Question: Write a single sentence explaining what this figure depicts.
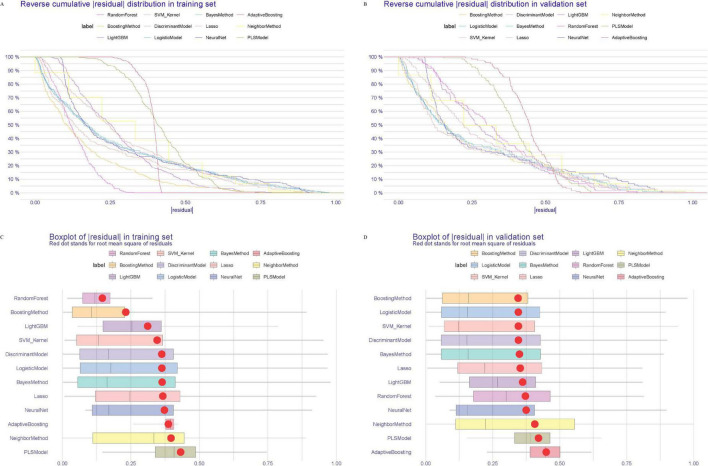
Answer: Residual distribution analysis of machine learning models. (A) Reverse cumulative absolute residual distribution in the training set. (B) Reverse cumulative absolute residual distribution in the validation set (C) . Boxplot of absolute residuals in the training set. (D) Boxplot of absolute residuals in the validation set.